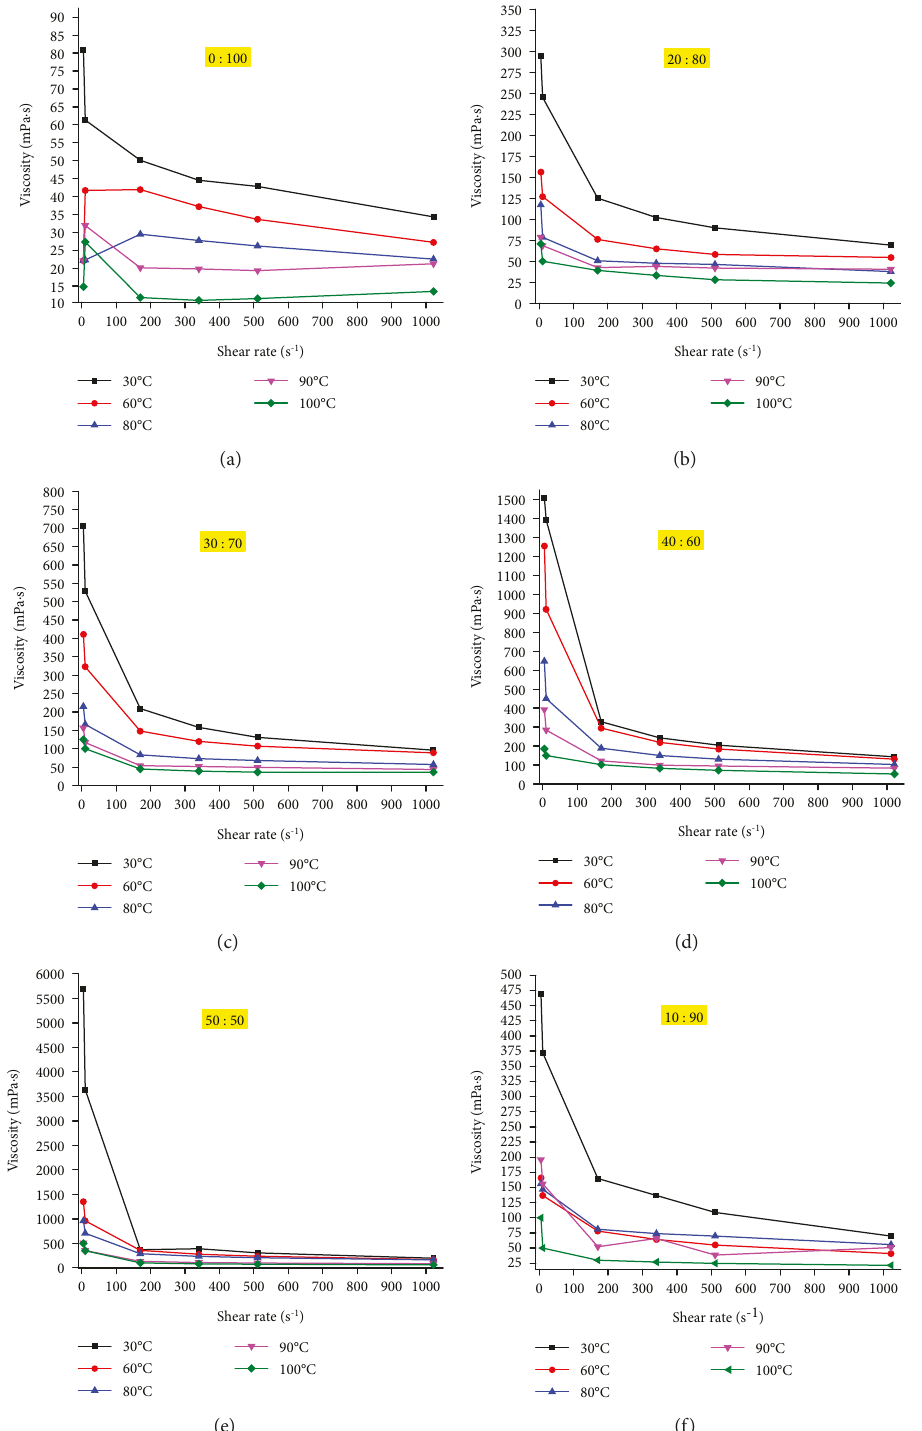
Figure 6: The relationship between apparent viscosity and shear rate of HEC emulsion solution having di ff erent oil-water